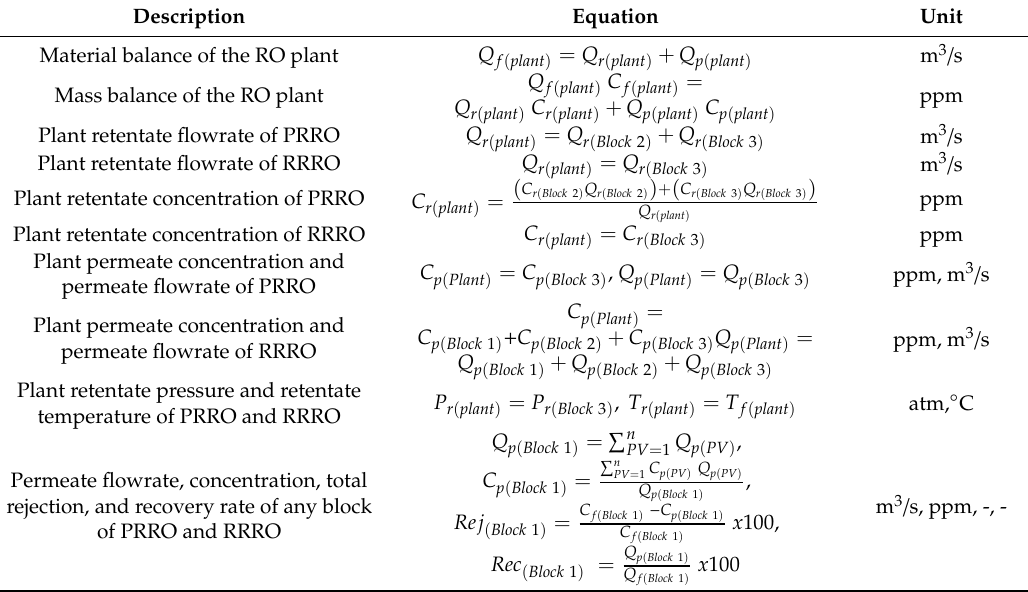
Table A3. Mathematical model of retentate reprocessing reverse osmosis and permeate reprocessing reverse osmosis designs of three blocks